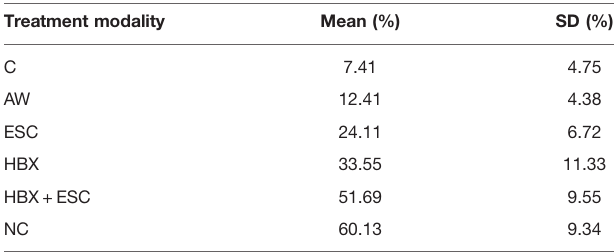
TABLE 3 | Mean and standard deviation of the percentage of implant surface covered by MG-63 cells in the fi ve different treatment groups and noncontaminated